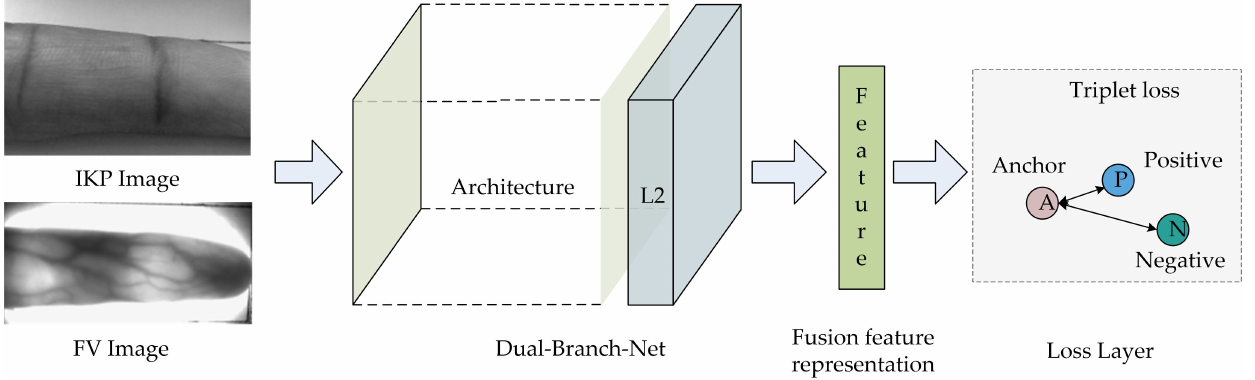
Figure 2. FV and IKP fusion network